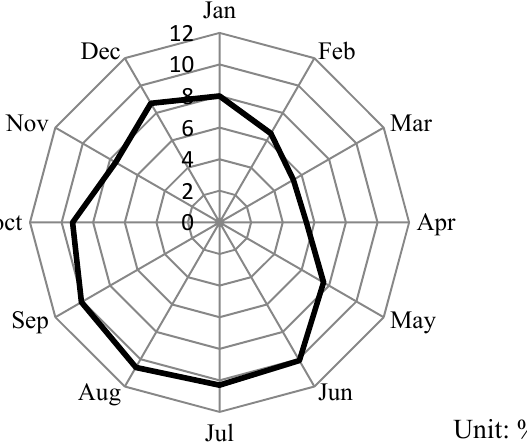
Figure 8. Drought in each month accounting for the percentage throughout the year. (The historical drought record data for validation were obtained from the 2002–2011 Chinese meteorological disaster almanac.